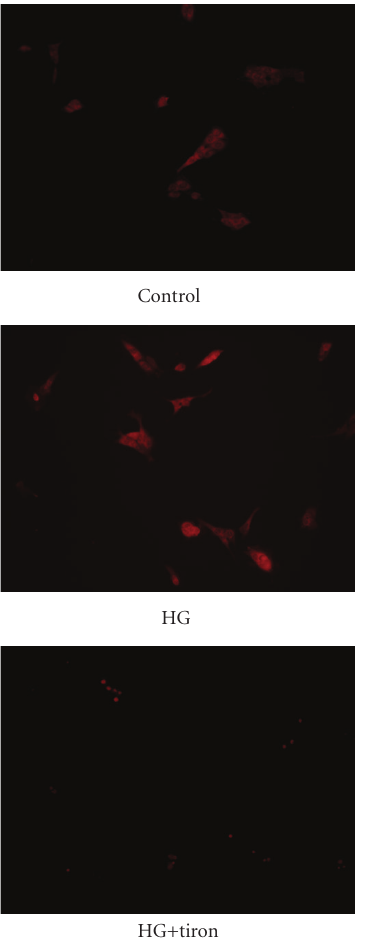
Figure 4: DHE stains were used to visualize the intracellular ROS in MDCK cells.